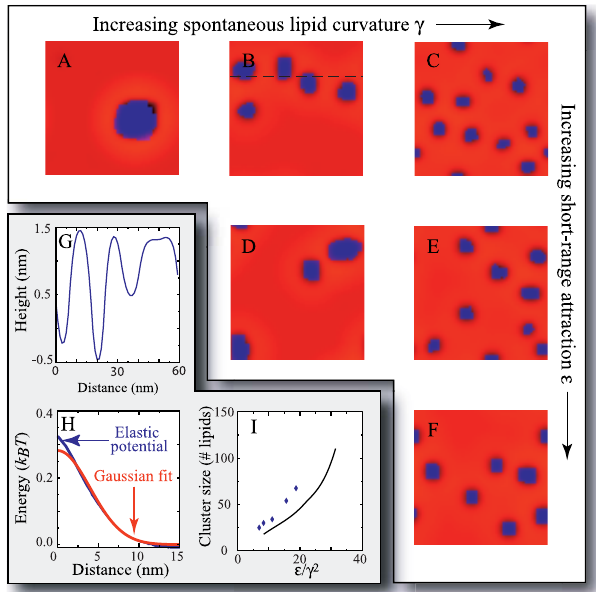
Figure 2. Lipid Cluster Size as a Function of Short-Range Attractive Interaction and Intrinsic Lipid Curvature (A–F) Representative distribution in a mixed membrane of lipids A and B, where lipid A has intrinsic curvature c , lipid B has no intrinsic curvature, and immediately neighboring lipids of the same type experience an attractive interaction e . The stiffness modulus ( j ¼ 25 k B T ), pinning modulus ( k ¼ 0.25 k B T /nm 4 ), and fraction of lipid A ( u ¼ 0.075) are the same in all panels. Blue indicates the presence of lipid A, while red represents the height of the membrane relative to the cell wall. (A–C) e ¼ 2.5 k B T, and c ¼ 0.2 nm (cid:1) 1 , 0.4 nm (cid:1) 1 , 0.6 nm (cid:1) 1 , respectively (D,E) e ¼ 3 k B T, and c ¼ 0.4 nm (cid:1) 1 , 0.6 nm (cid:1) 1 , respectively. (F) e ¼ 4 k B T and c ¼ 0.6 nm (cid:1) 1 . (G) Height profile of the membrane along the dashed black line in (B). (H) The long-range repulsive elastic interaction between two lipids is well fit by a Gaussian. (I) Average cluster size as a function of e / c 2 . Results of simulations are shown with blue dots, while the black line represents the theoretical prediction based on minimizing free energy per